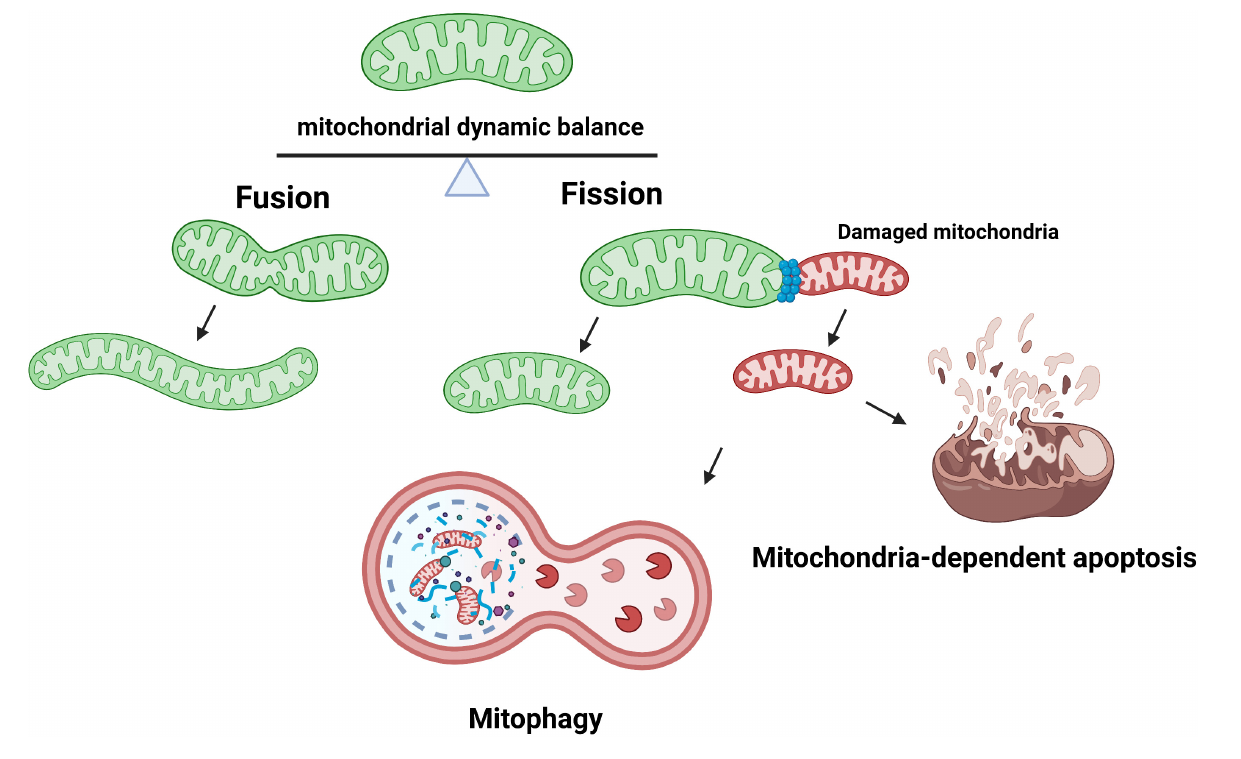
FIGURE 2 | Mitochondrial dynamics and quality control. Mitochondria fuse to merge intra-organelle contents including the mitochondrial DNA and prevent permanent loss of essential components. The fusion process is mediated by the GTPase proteins mitofusins 1 and 2 (MFN1/2) on the mitochondrial outer membrane, and optic atrophy type 1 (OPA1) on the mitochondrial inner membrane. Mitochondrial fission, on the other hand, can create new mitochondria or enable quality control by segregating damaged mitochondria for subsequent degradation via mitophagy. The fission process is primarily carried out by dynamin-related protein 1 (DRP1) and mitochondrial outer membrane mitochondrial fission 1 protein (FIS1). If mitochondria quality control is dysfunctional, the mitochondria may induce mitochondria-dependent